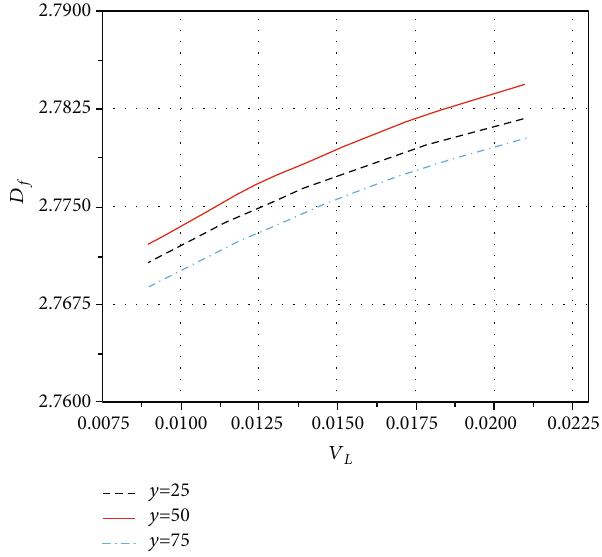
Figure 14: In fl uence of Langmuir volume constant V length fractal dimension D